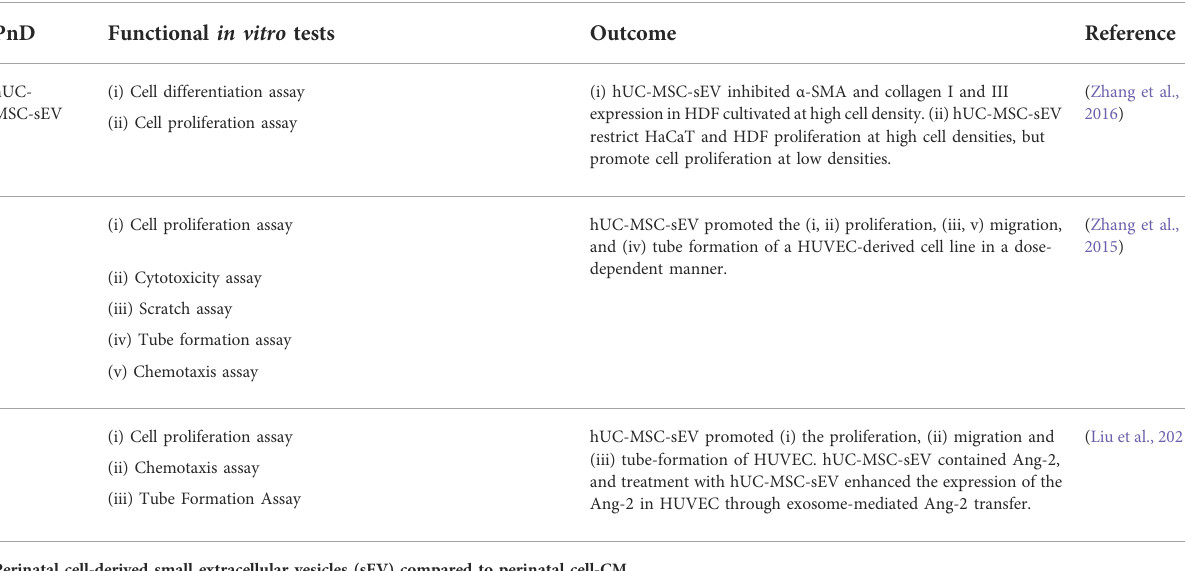
TABLE 3 Functional tests on Perinatal cell-derived small extracellular vesicles (sEV) alone or compared to perinatal cell-conditioned medium (CM). Perinatal cell-derived small extracellular vesicles